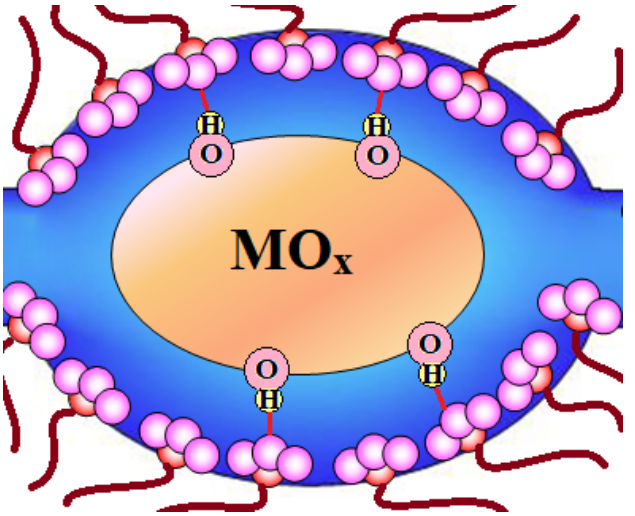
Figure 8. Scheme of the salt bridge (M n+ –OSO 2 − ) formation in hybrid membranes with base oxide nanoparticles.